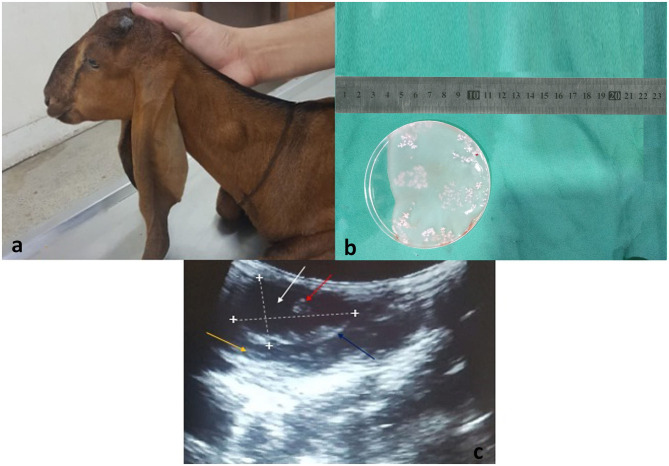
(a) A goat presented to the CMS Department of University of Agriculture, Faisalabad, Pakistan with a swollen mass around the neck region. (b) Surgically isolated Coenurus cerebralis cyst from the neck region of a goat. Scolices are attached to the internal layer of the cyst (white clusters). (c) Ultrasound scan of T. multiceps cyst in goat. Lengthwise and widthwise boundaries of the cyst are demarcated with dotted lines and plus (+) signs. The yellow arrow indicates the host's muscular layer, blue arrow indicates hypoechoic cyst wall, white arrow indicates anechoic cystic fluid, and red arrow indicates protoscolices.